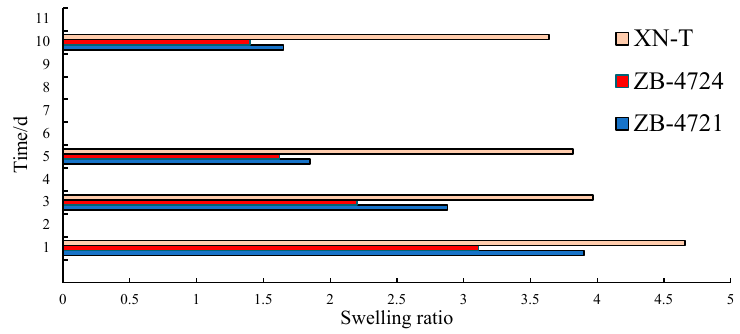
Figure 2. Comparison of three types of swelling retarding particles by swelling ratio.